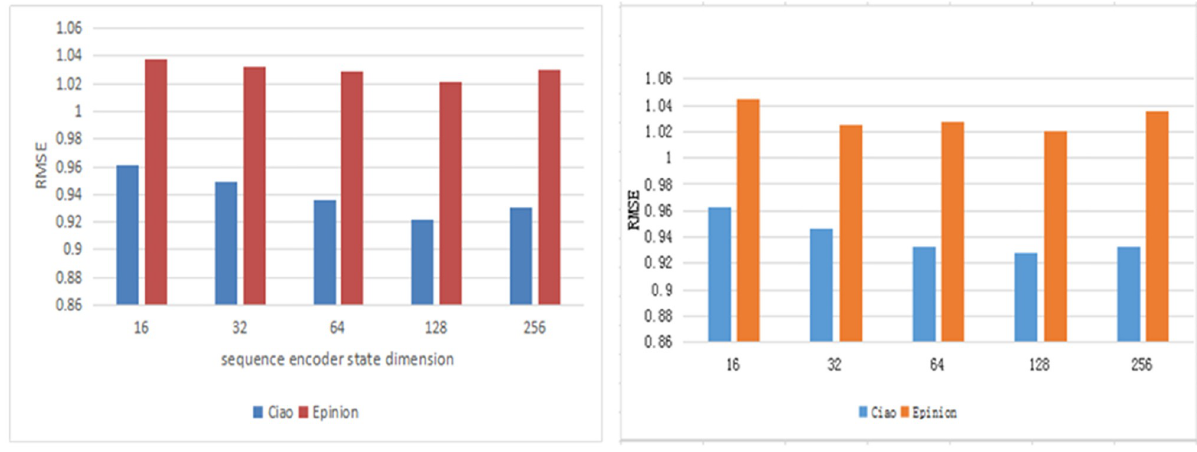
Fig 5. Validation RMSE as a result of varying d x , d y